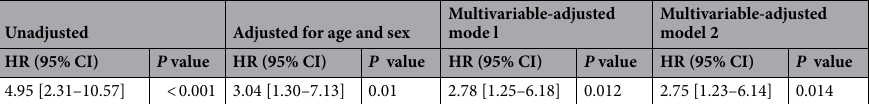
Table 3. Association between higher sCys C level and severe COVID-19 illness. Abbreviations: sCys C = serum cystatin C; COVID-19 = coronavirus disease 2019; HR = Hazards ratio; Multivariable Model 1: Adjusted for age, sex, increased lactate dehydrogenase, decreased lymphocyte, and qSOFA (Quick Sequential Organ Failure Assessment). Multivariable Model 2: Adjusted for age, sex, increased lactate dehydrogenase, decreased lymphocyte, and vascular risk factor